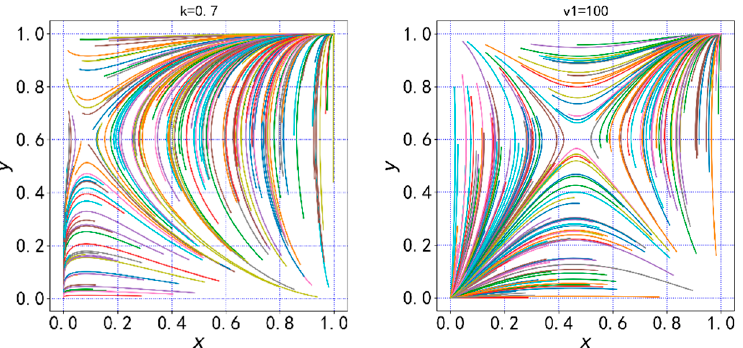
Figure 7. Simulation results chart for k = 0.7, v 1 = 100.